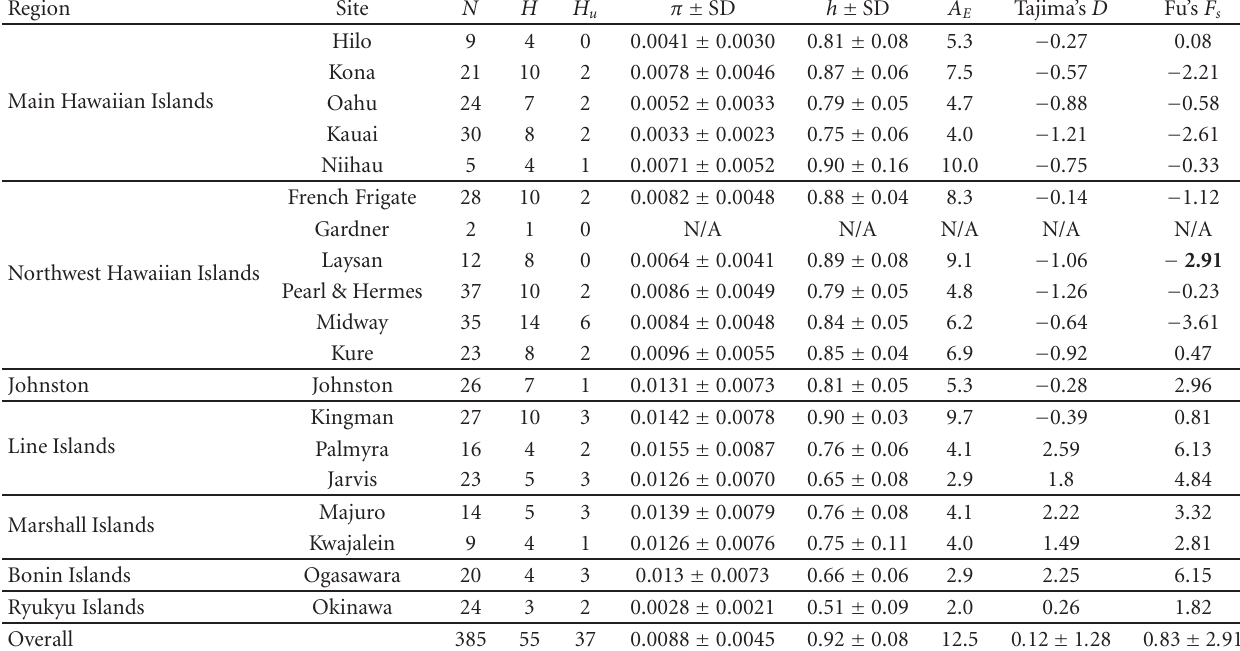
Table 1: N is the Sample size, H is the total number of haplotypes, H u is the number of unique haplotypes at site, π is the nucleotide diversity, h is the haplotype diversity, and A E is the e ff ective number of alleles in COI.